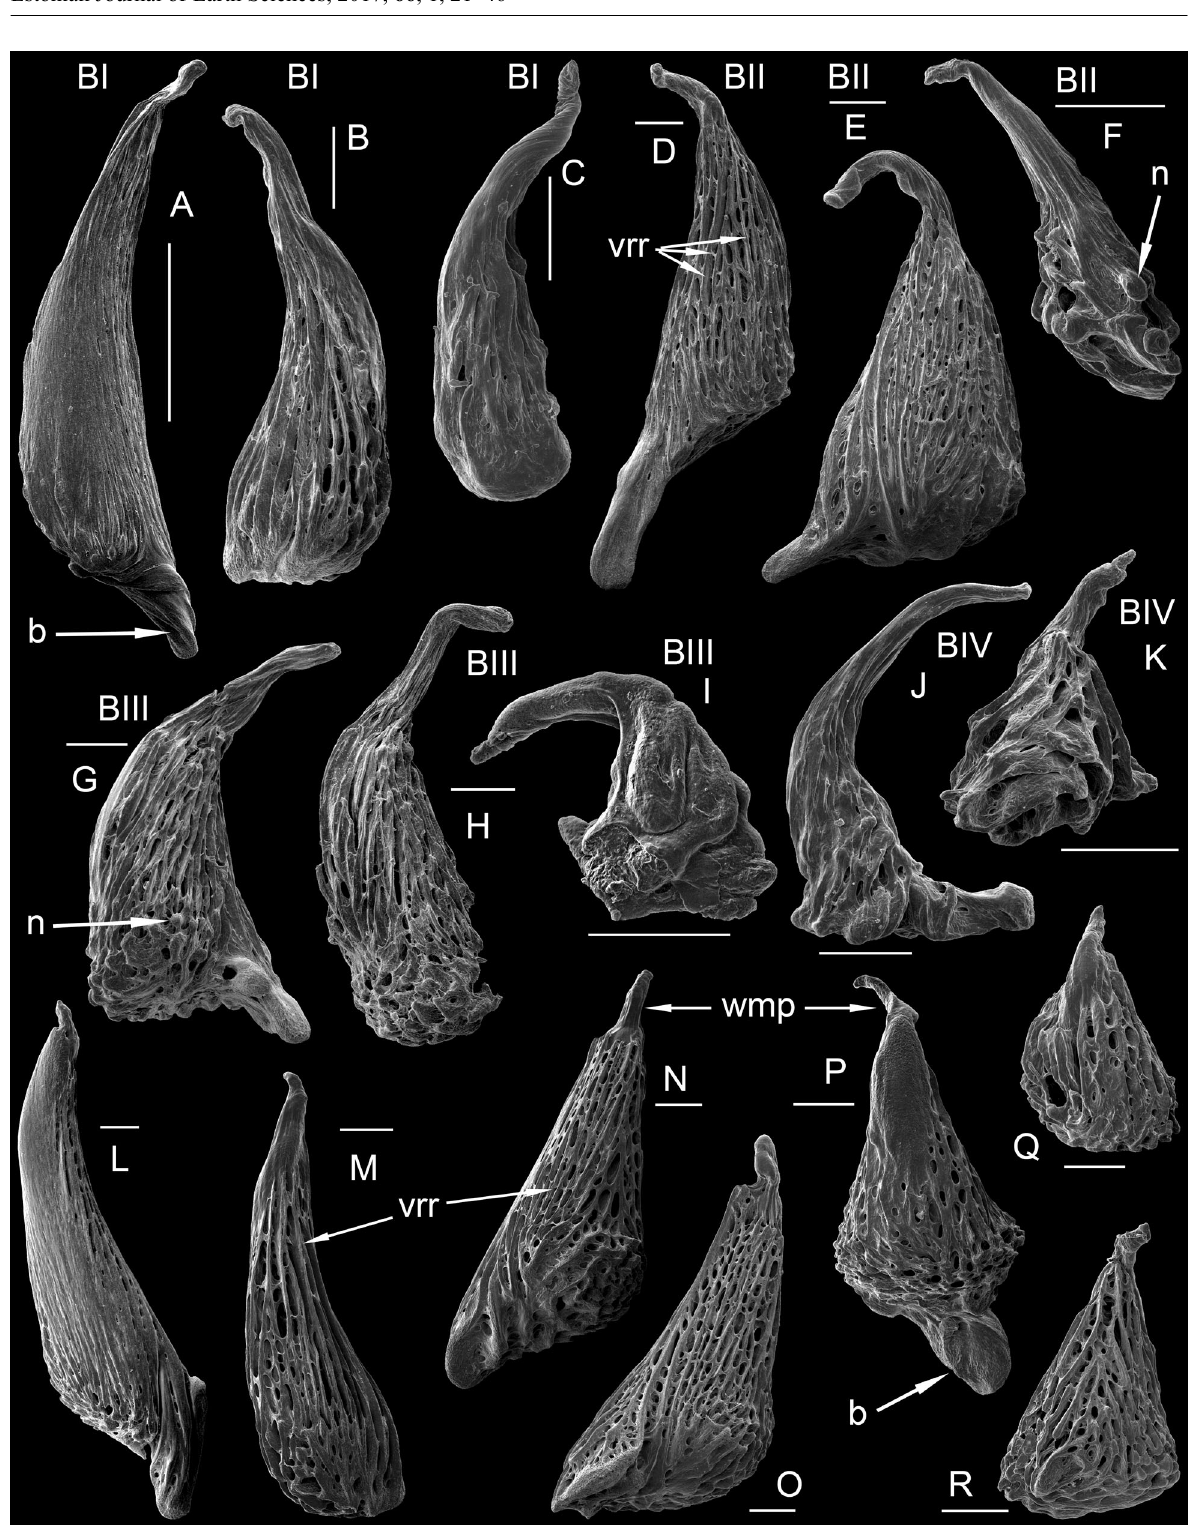
Fig. 4. Pleuronectes platessa Linnaeus. Cores of gill rakers from the 1st to 4th arches of the blind side (BI–BIV). A, GIT 584- 121-5; B, GIT 584-121-7; C, GIT 584-121-6; D, GIT 584-121-12; E, GIT 584-121-13; F, GIT 584-121-14; G, GIT 584-121-17; H, GIT 584-121-18; I, GIT 584-122-9; J, GIT 584-121-25; K, GIT 584-121-26; L, GIT 584-89-44; M, GIT 584-89-47; N, GIT 584-89-52; O, GIT 584-89-46; P, GIT 584-89-51; Q, GIT 584-89-48; R, GIT 584-89-45. Scale bar for A is 1 mm, for B–Q 200 μ m. For abbreviations see Fig.